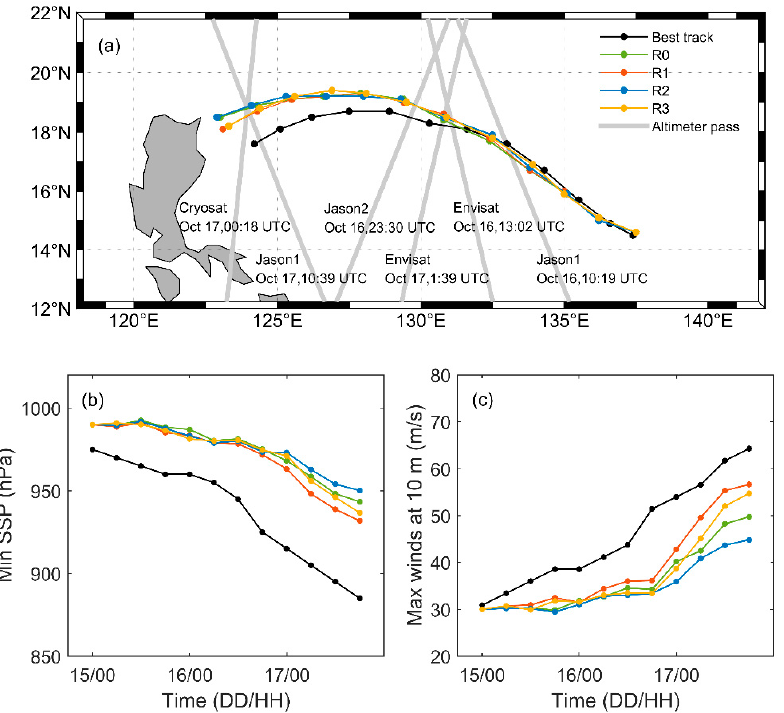
Figure 3. JMA best track data for Megi and simulated results from four different numerical experi- ments at 6 h intervals from 00:00 UTC 15 October to 18:00 UTC 17 October 2010. ( a ) Track; ( b ) min- imum sea surface pressure; ( c ) maximum wind speed at 10 m. Grey lines in panel ( a ) indicate the ground tracks for altimeters Jason-1, -2, Cryosat, and Envisat during the period covered in the Megi simulations. See Table 1 for details of the different numerical experiments.